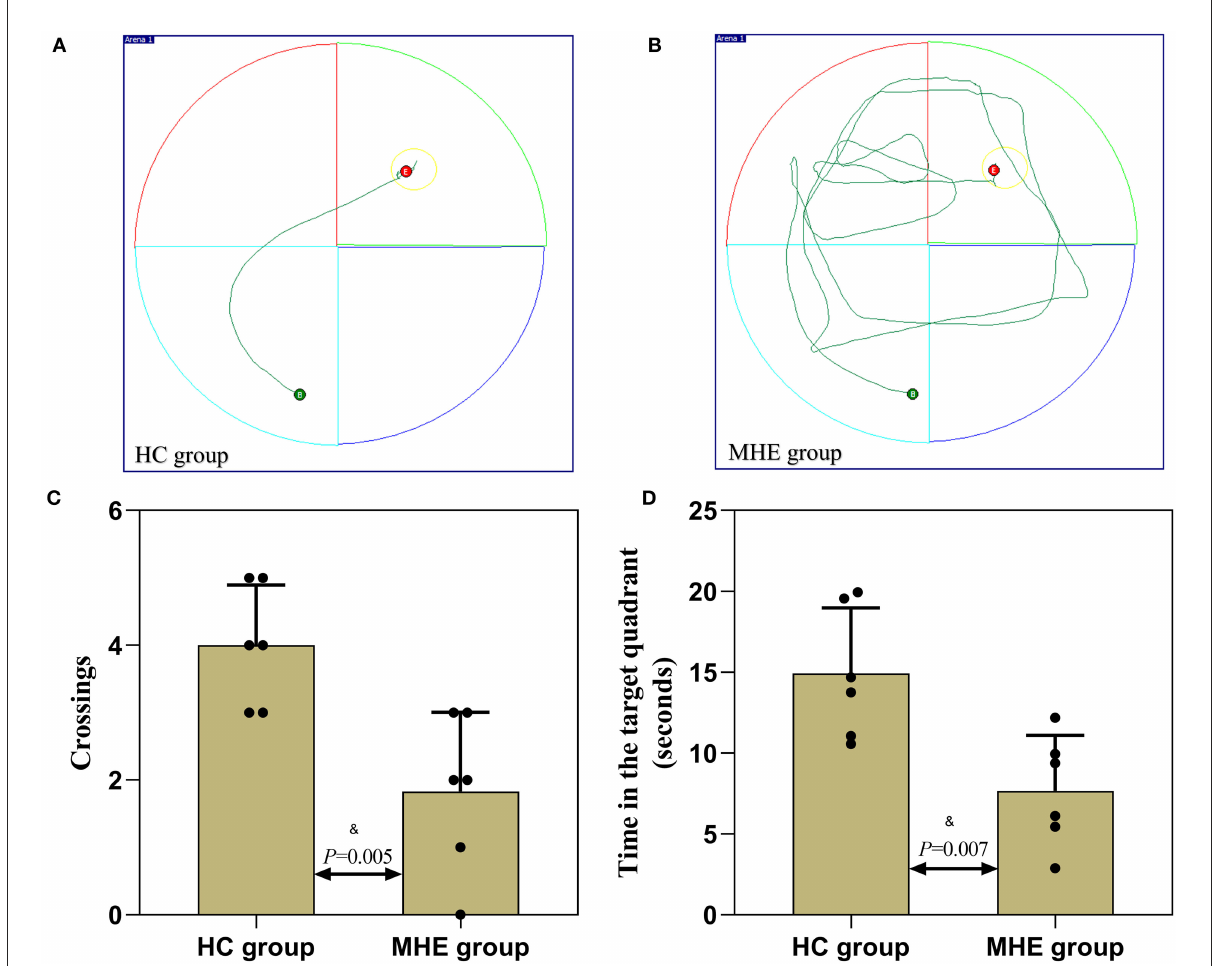
FIGURE4 Spatial memory performance of MHE and control rats. (A,B) are the representative trace in the water maze task; (C) The number of times crossed the platform in the spatial probe test; (D) The time spent in the target quadrant in the spatial probe test; & Student’s t -test.